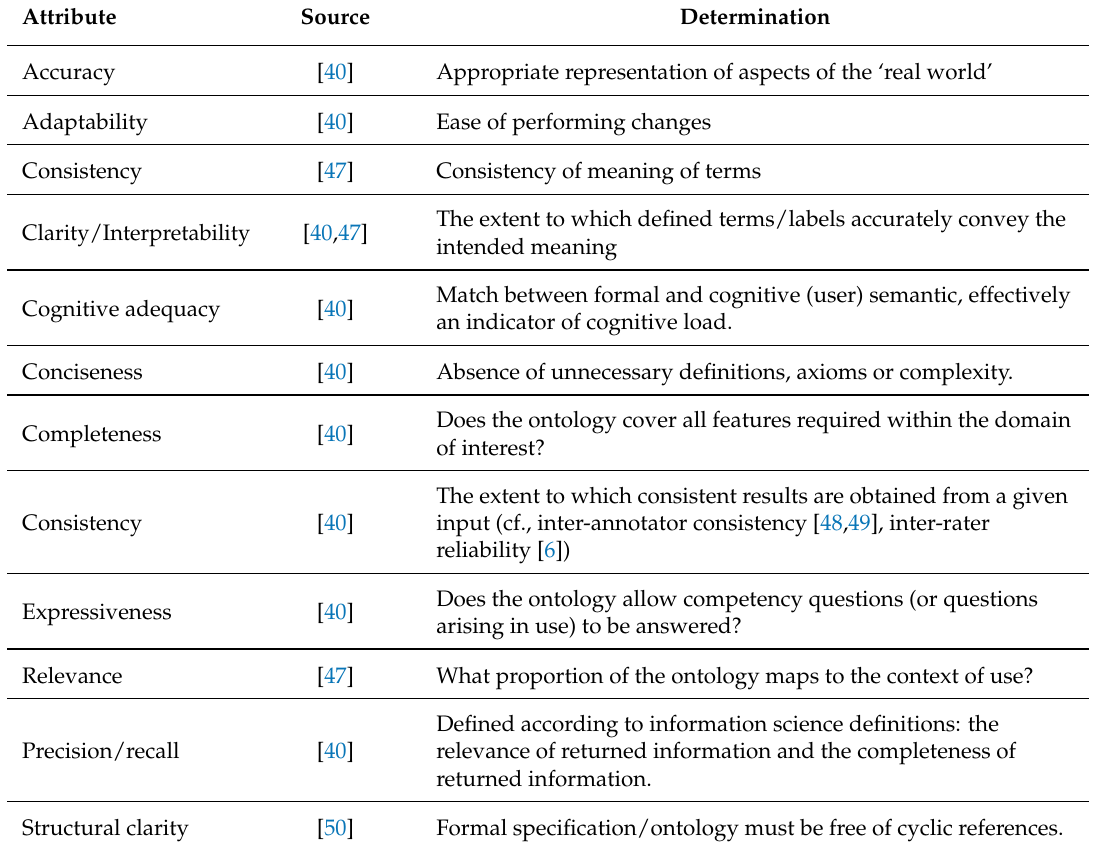
Table 5. Desirable characteristics of an ontology in a given context of